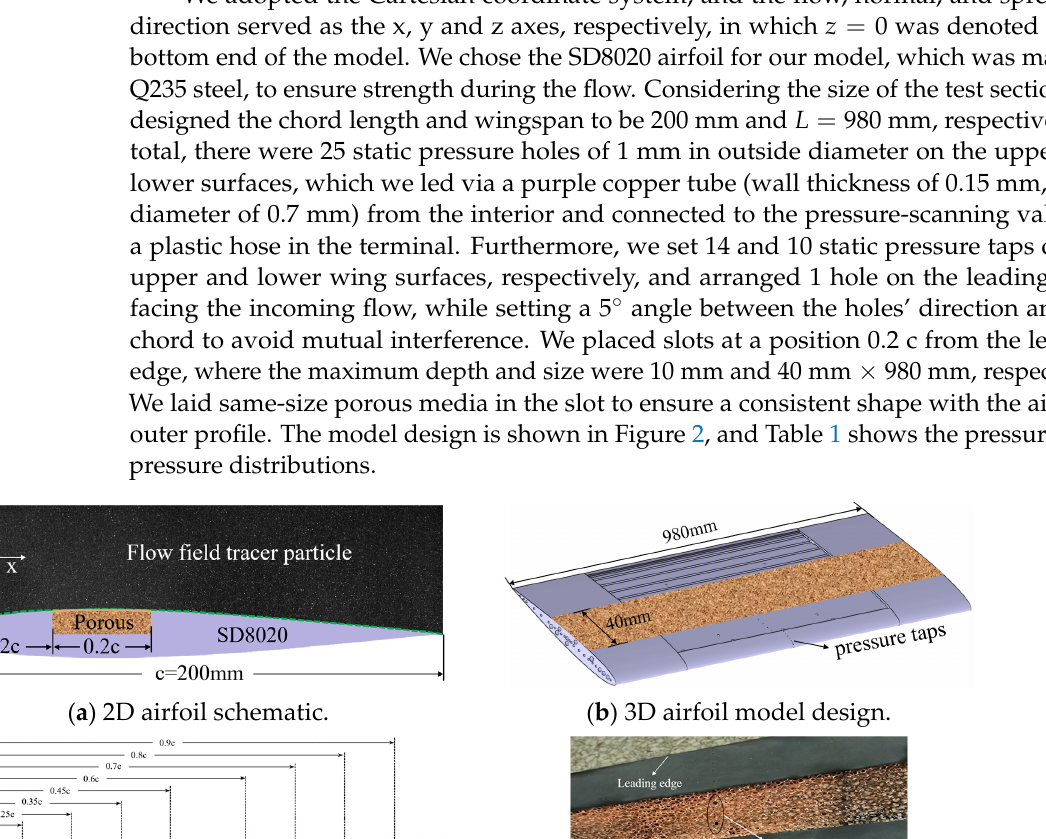
Figure 1. Experimental physical layout.